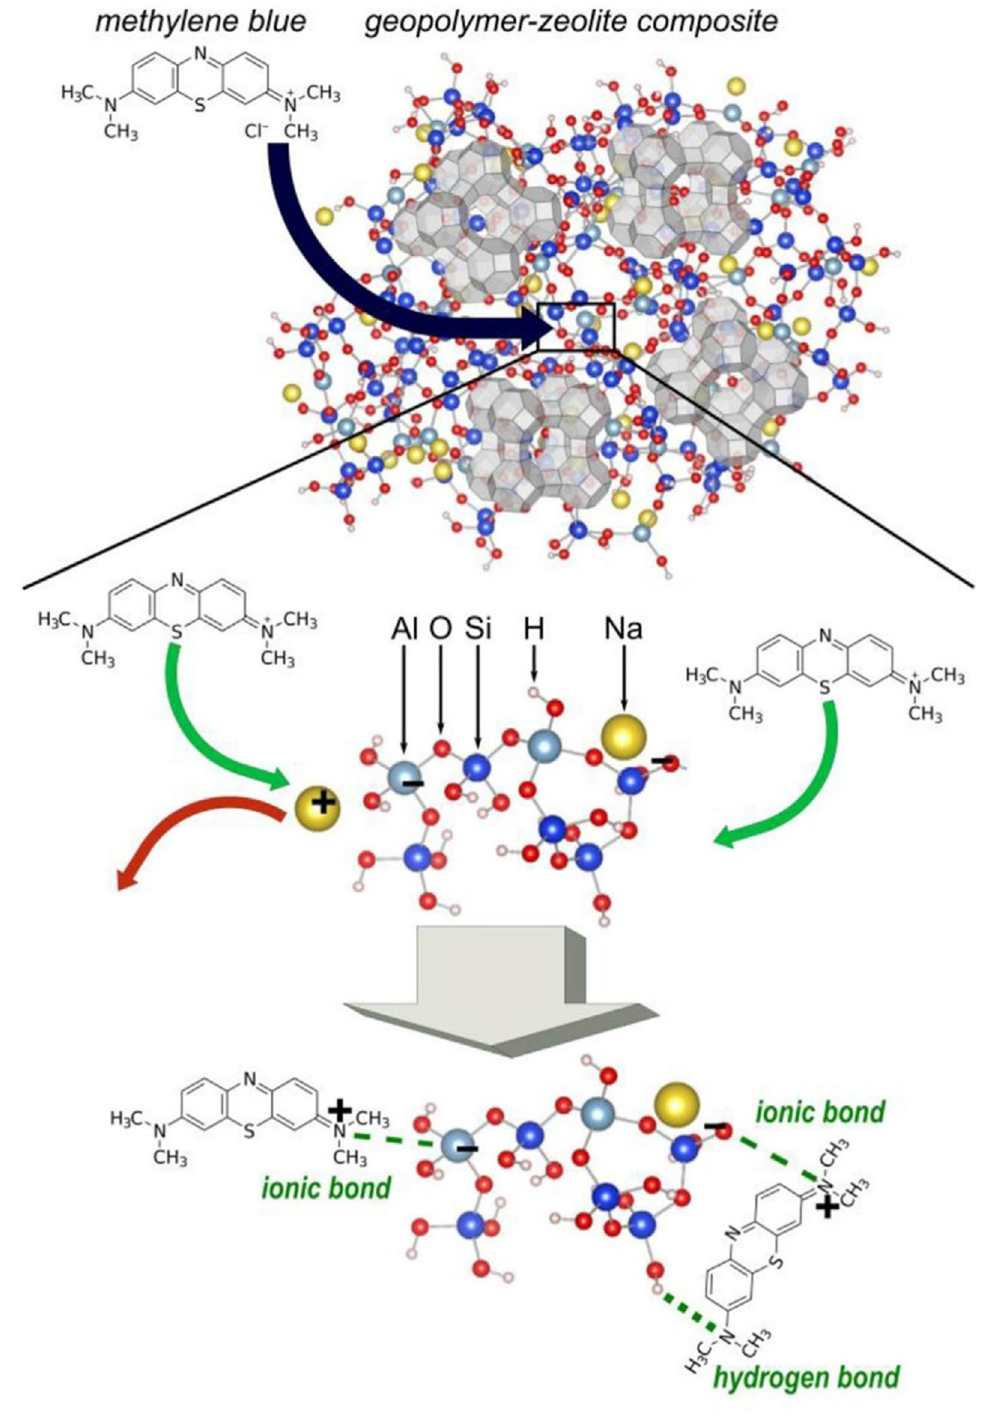
Fig. 31 MB dye adsorption mechanism over zeolite/geopolymer composites (Zhang et al. 2021a,